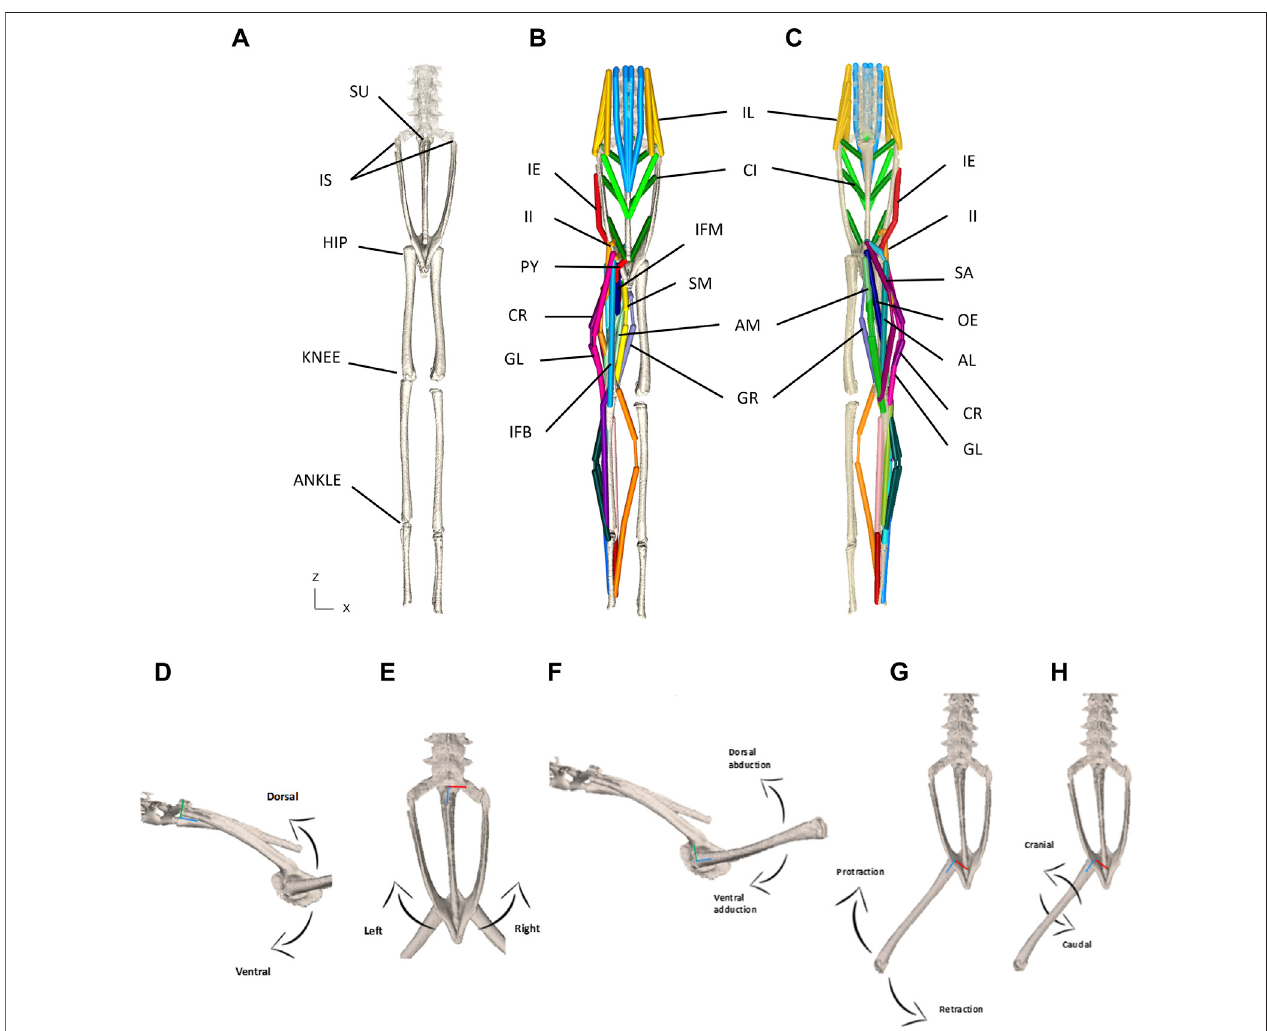
depictingprotraction/retractionaboutthe Y axis. (H) — Dorsalviewdepictingcranial/caudallongaxisrotationaboutthe Z axis.The X axesarered, Y axesaregreen,and Z axes are